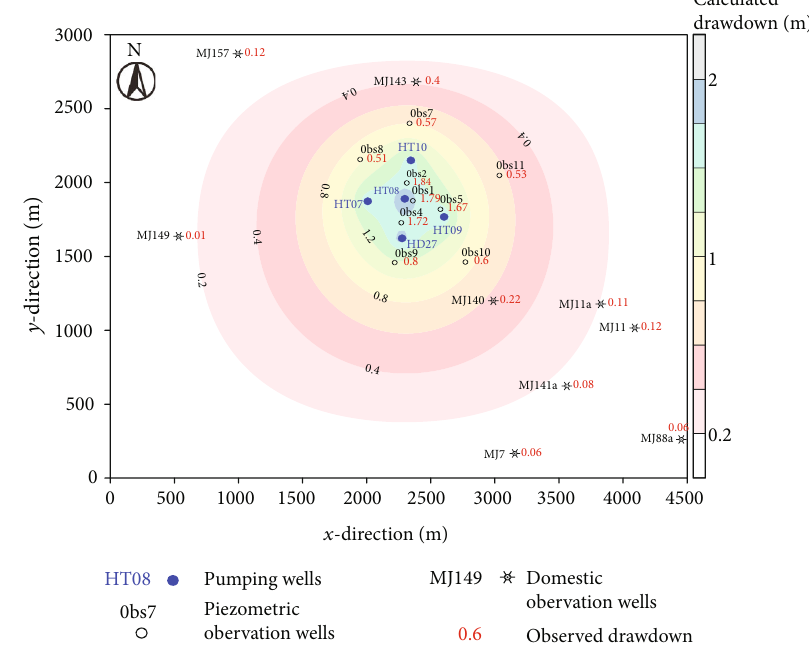
Observed drawdown0.6